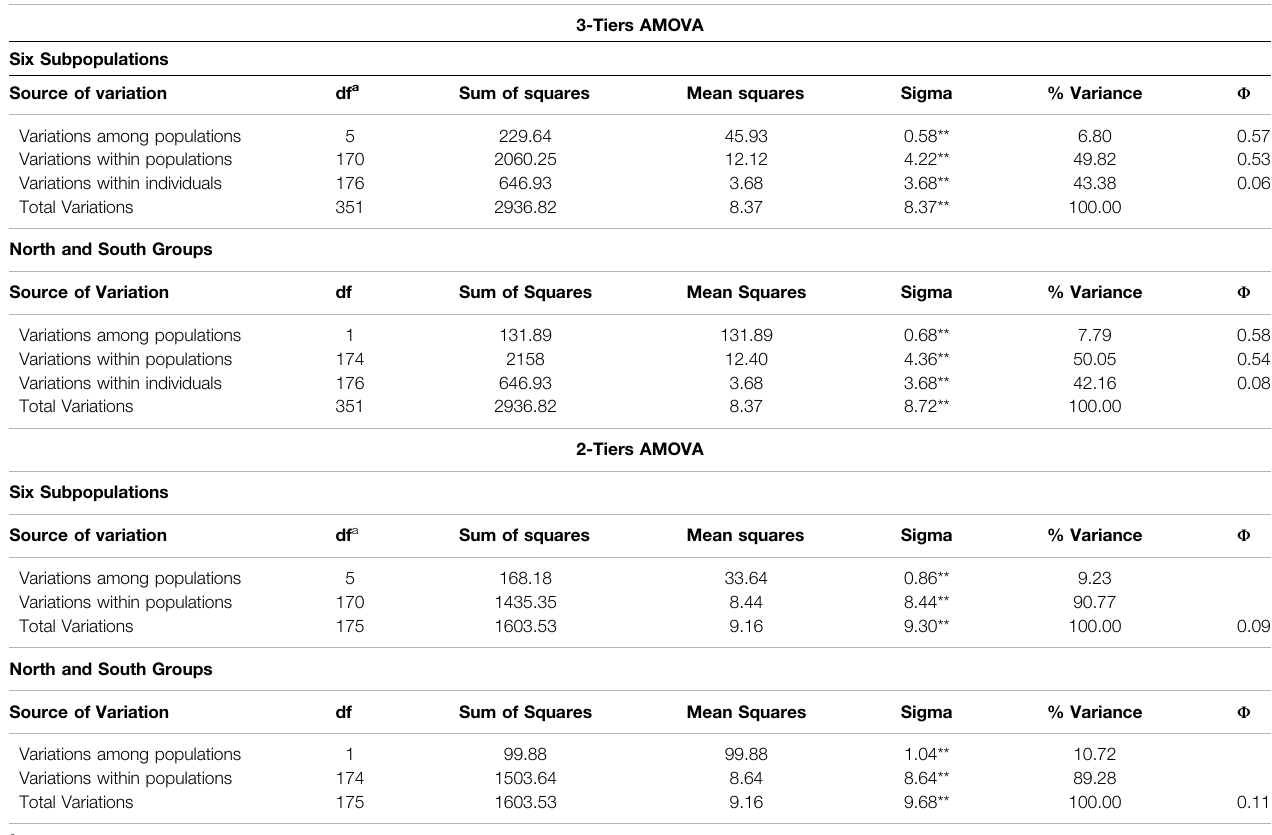
TABLE 3 | AMOVA of trees genotyped in the Pyrus calleryana dataset using six subpopulations and North/South Groups. AMOVA was performed at 3-tiers and 2-tiers without “ Variations within individuals ” in independent